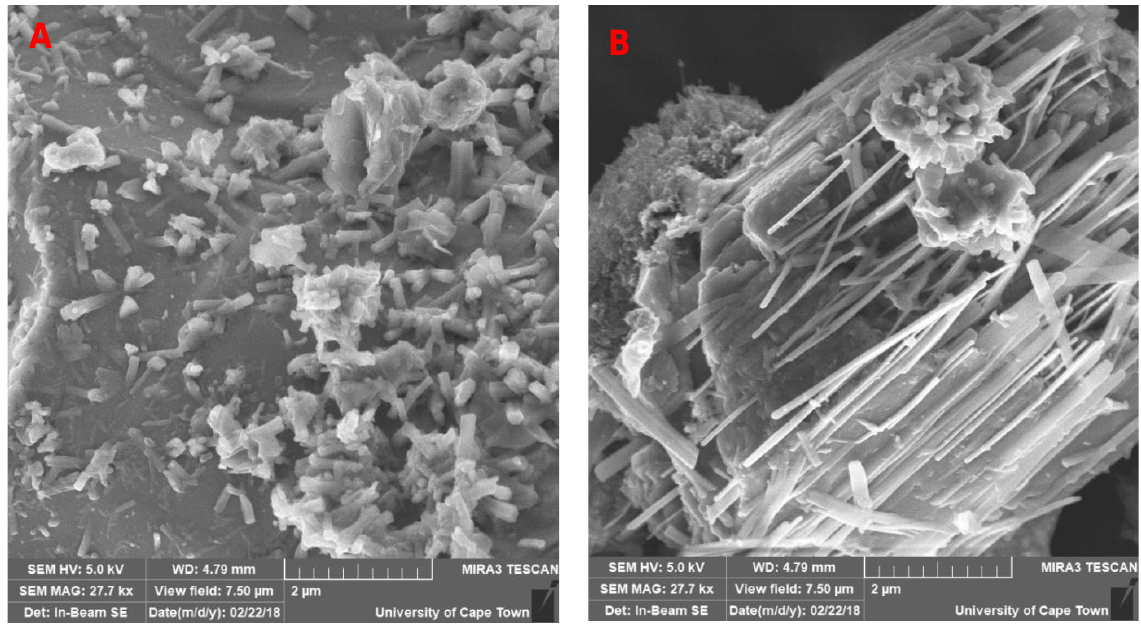
Figure 6: SEM-SE images of cement surface hydrated for 1 hour and prepared with (A) natural gypsum and (B) hemihydrate.